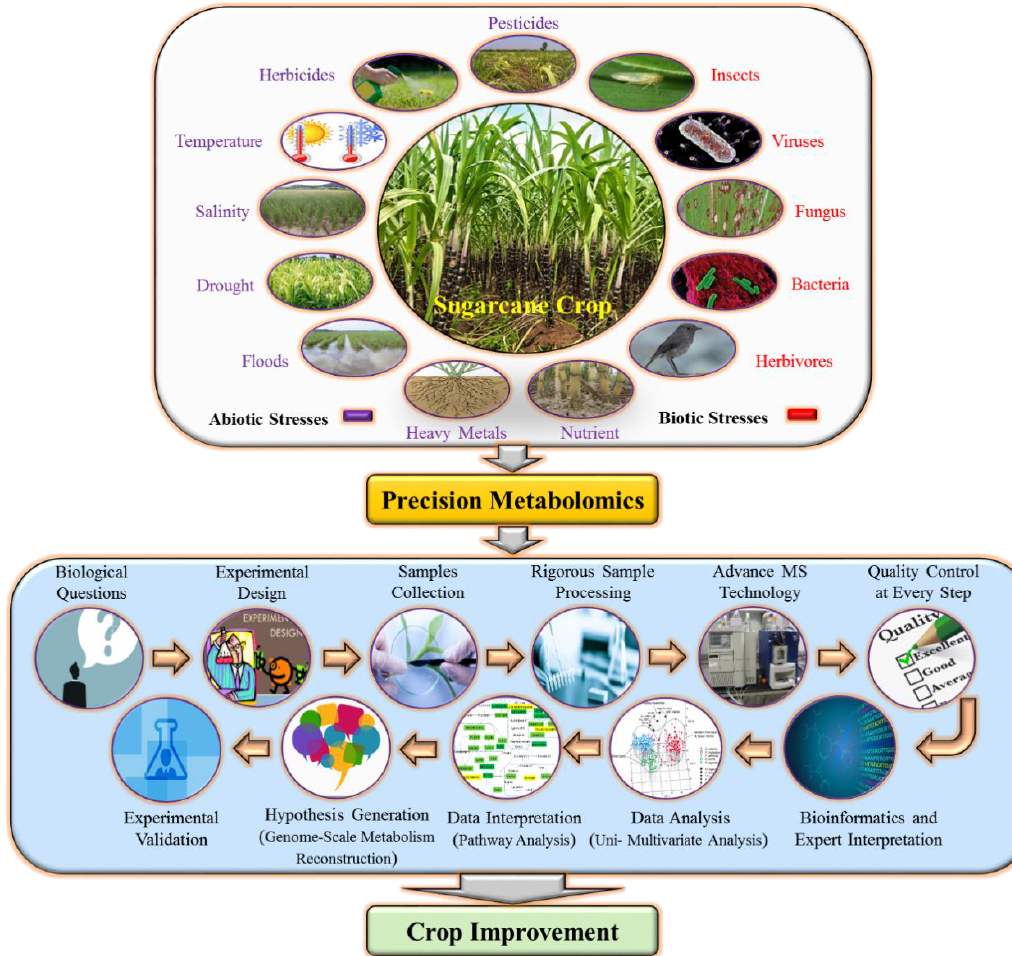
Figure 4. Sugarcane precision metabolomics studies: A useful tool to discover metabolome alterations during abiotic and biotic stresses and major routes of generating metabolomics data. Table 1. Summary of sugarcane metabolites and their role in plant growth and stress responses.